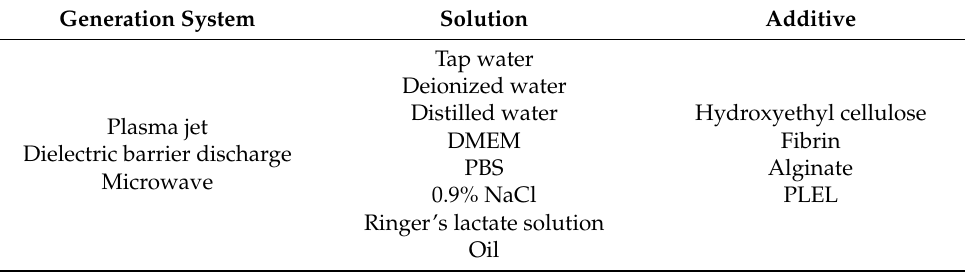
Table 1. Possible options for PAL